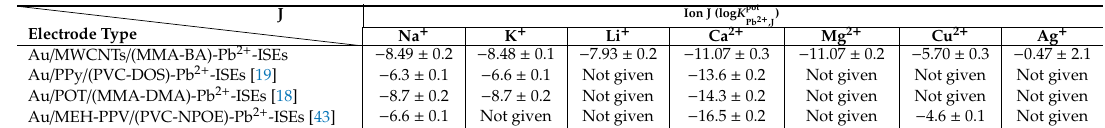
Figure 5. The response slopes profile for Pb 2+ ( ○ ) and interfering ions, including Na + ( * ), K + ( ◇ ), Ag + ( ☆ ), Cu 2+ ( ＋ ), Ca 2+ ( △ ), Mg 2+ ( × ), and Li + ( □ ). Table 3. The potentiometric selectivity coe ffi cients (log K pot Au / MWCNTs / (MMA-BA)-Pb 2 + -ISEs compared to those available Pb 2 + -selective solid-contact electrodes with Au disk electrodes. ( n =